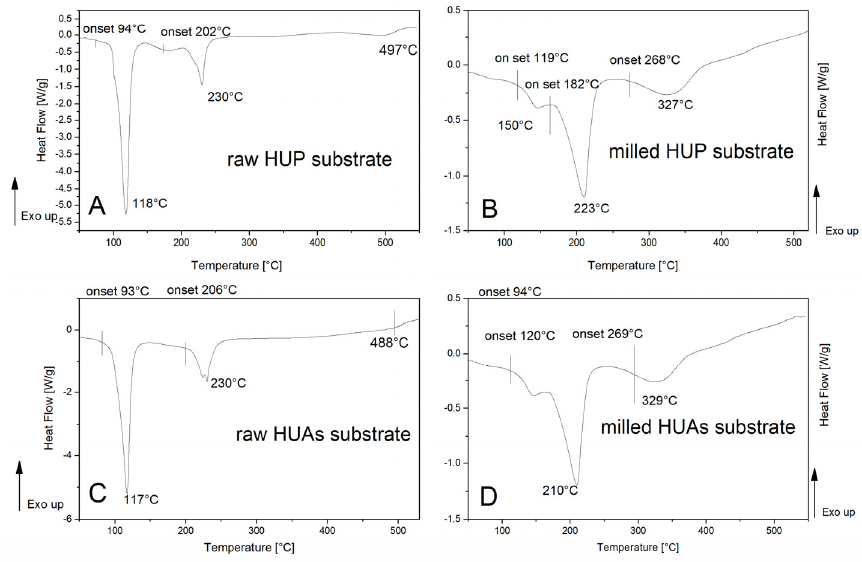
Figure 1. DSC traces registered for pristine materials: raw ( A ) and milled ( B ) HUP (UO 2 )(HPO 4 ) (H 2 O) 4 and raw ( C ) and milled ( D ) HUAs (UO 2 )(HAsO 4 )(H 2 O) 4 .